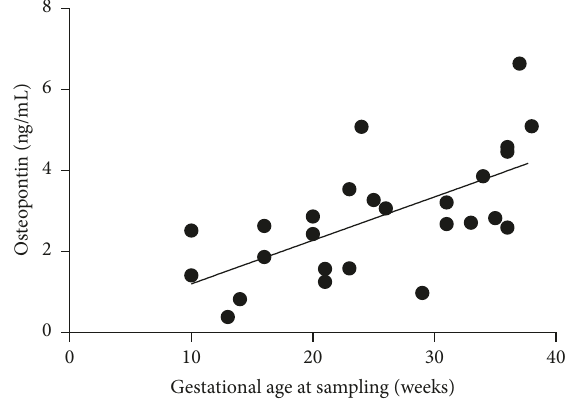
Figure 2: Positive correlation of gestational weeks at sampling to circulating osteopontin in asthmatic pregnant patients. 𝑝 < 0.0001 ; 𝑟 = 0.6924 .